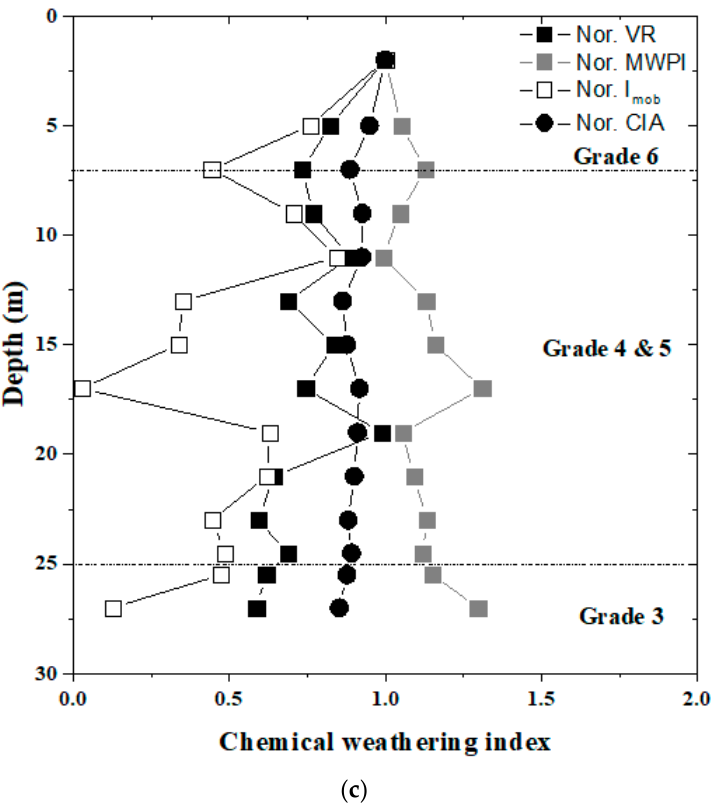
Figure 7. Distribution of normalized chemical weathering indices: ( a ) A site; ( b ) G site; ( c ) S site.